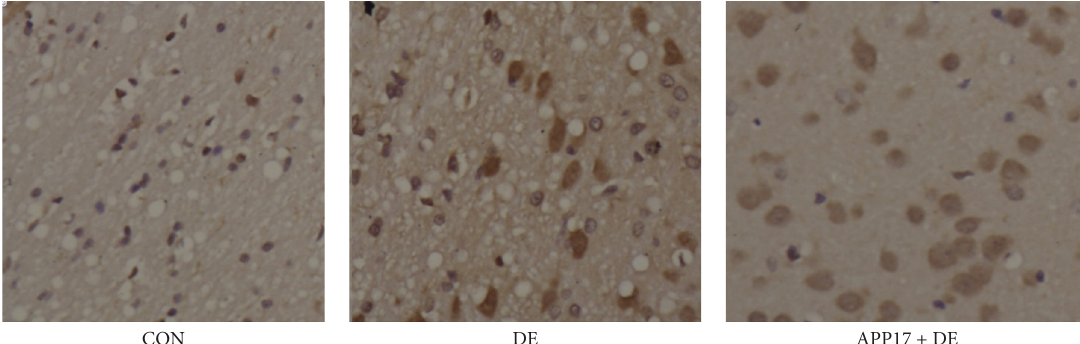
Figure 4: Enhanced GLUT4 expression in the hippocampal gyrus of DE rats with APP17 treatment.